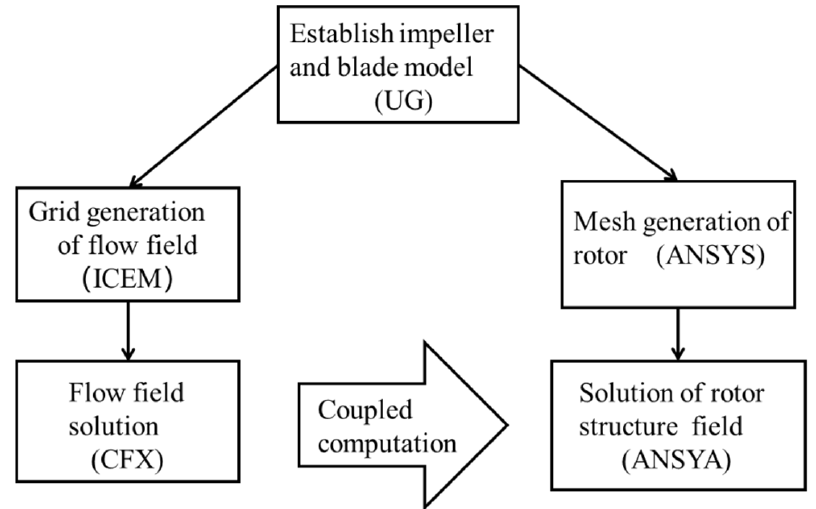
Figure 6. Flow chart of fluid-structure coupling calculation.